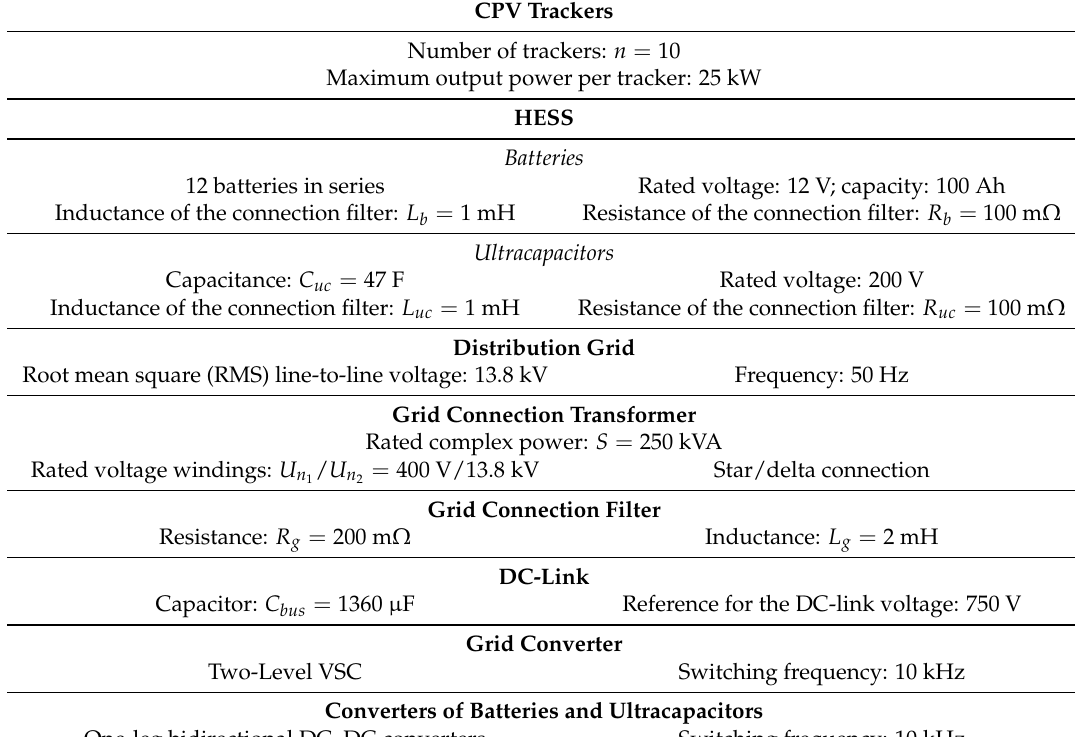
Table 1. Parameters of the concentration photovoltaic (CPV) plant simulated in